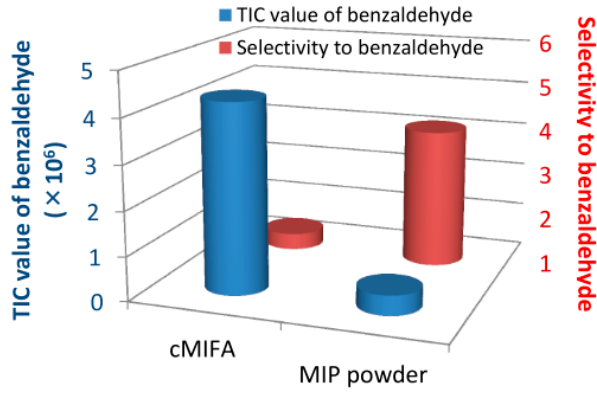
Figure 8. The comparison of the adsorption capability and selectivity of molecularly imprinted filtering adsorbents and MIP powder [39].